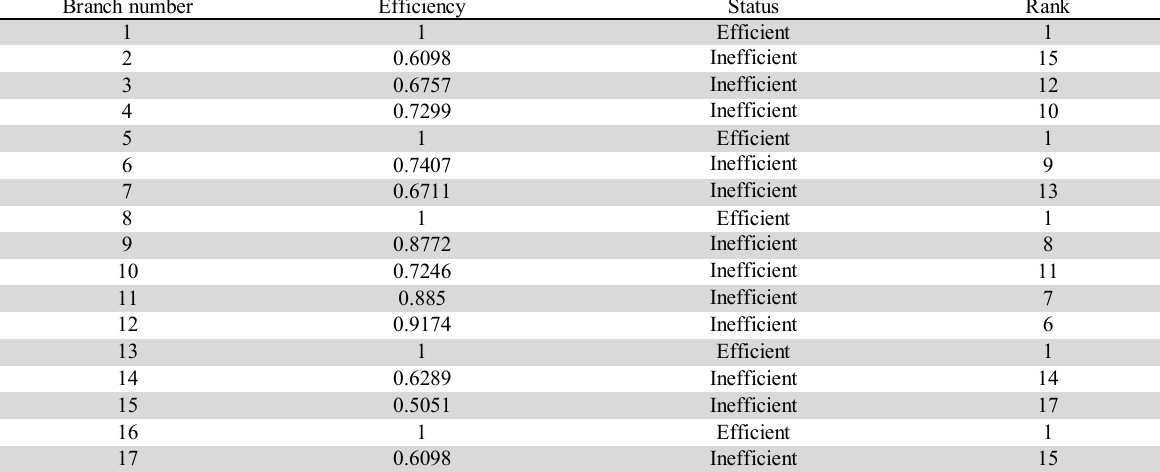
The relative efficiency of 17 units based on the DEA